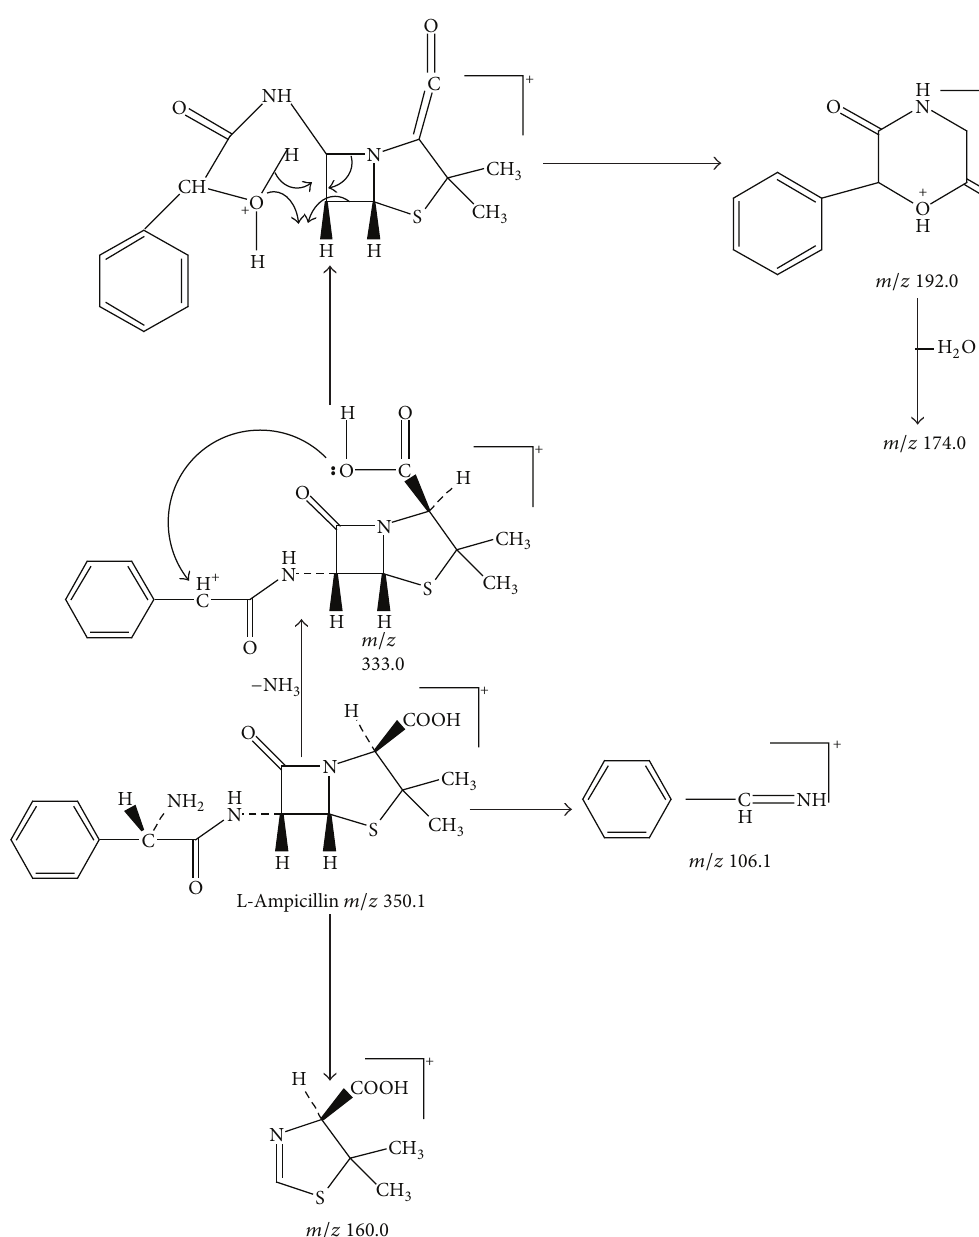
Figure 5: Proposed fragmentation pathways and characteristic ions of protonated L-ampicillin ( 𝑚/𝑧 350).